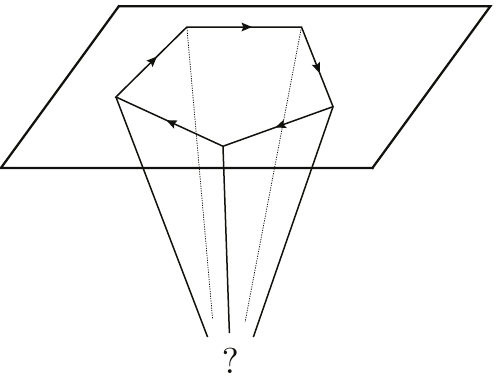
Figure 1. Cosmological observations can be traced back to the end of in(cid:13)ation where they become spatial correlations on the boundary of the approximate de Sitter